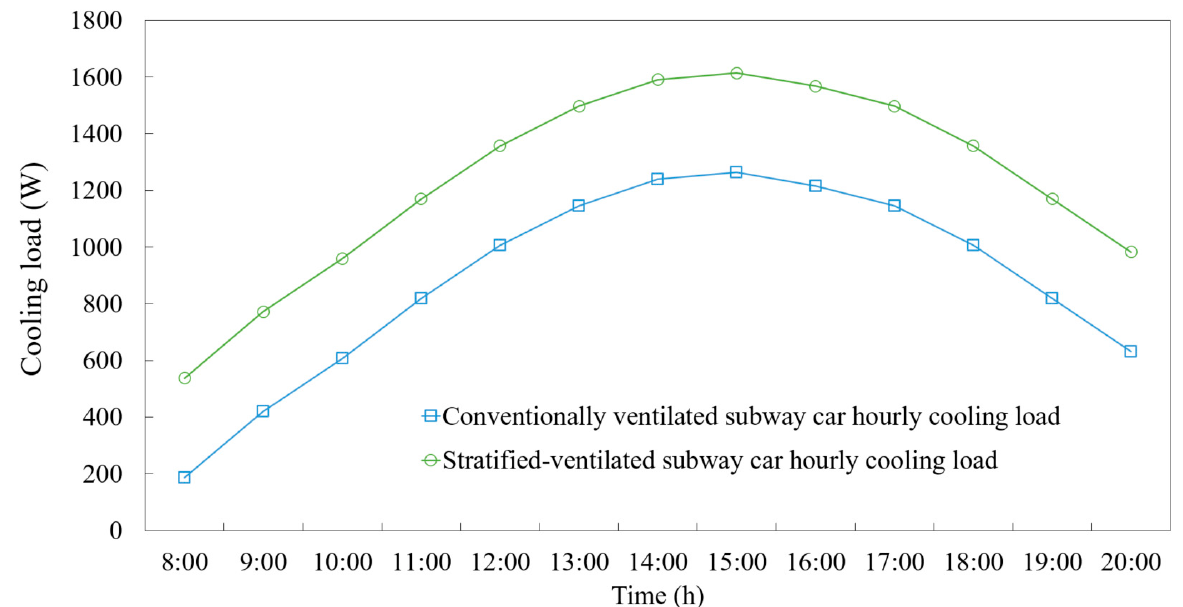
Figure 10. Hourly cooling loads of the subway cars equipped with CV and SV under representative summer weather conditions.